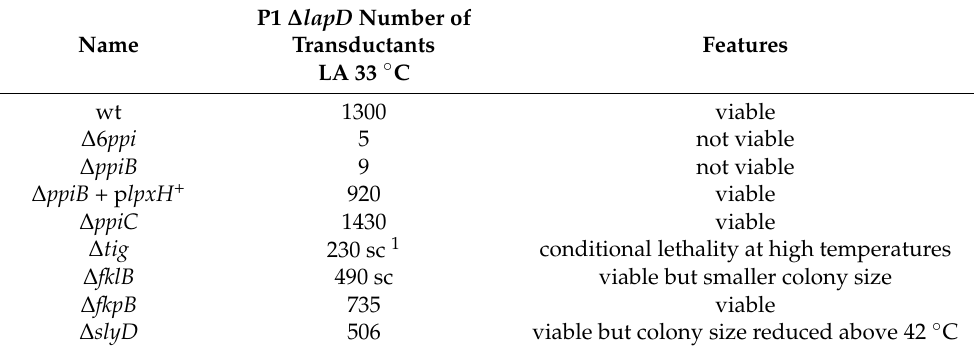
Table 4. Requirement of LapD in strains lacking cytoplasmic